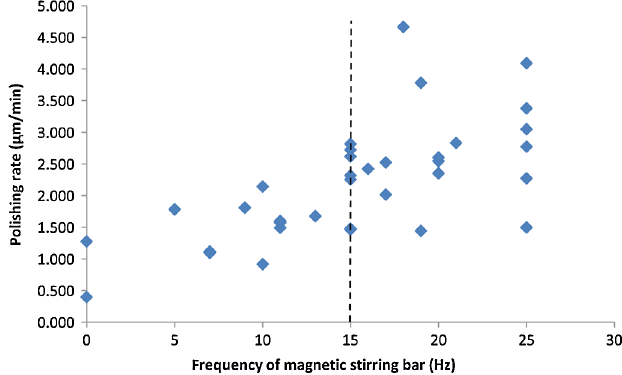
FIG. 5. (Color) The effect of temperature on polishing rate from all the experiments including those with different acid flow rates.